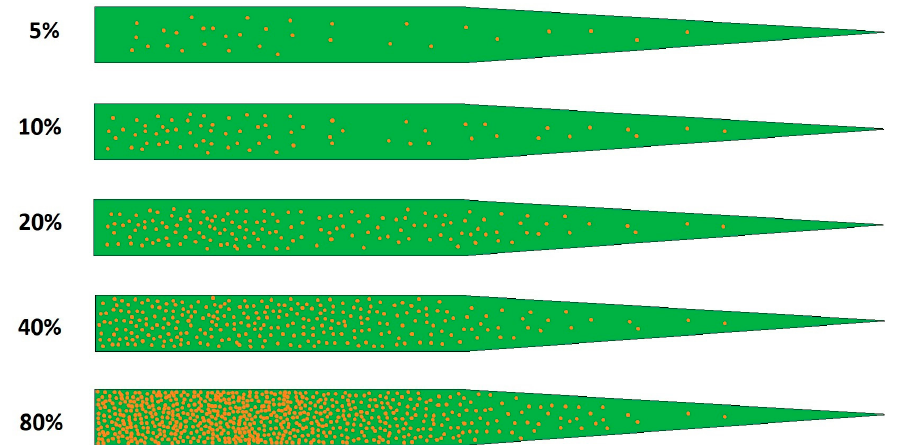
Figure 1. Simplified scale of brown rust infestation on wheat flag leaf, based on the percentage coverage of the leaf by uredia.